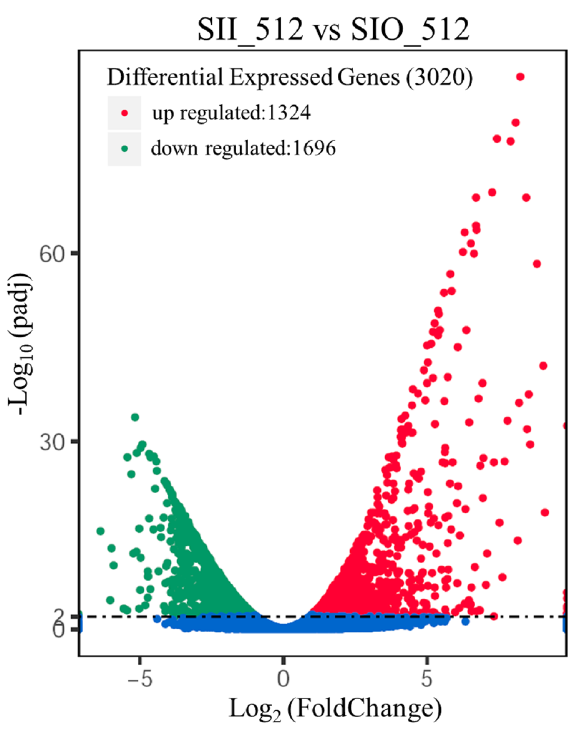
Figure 2. Volcano of differentially expressed genes between samples from SII and